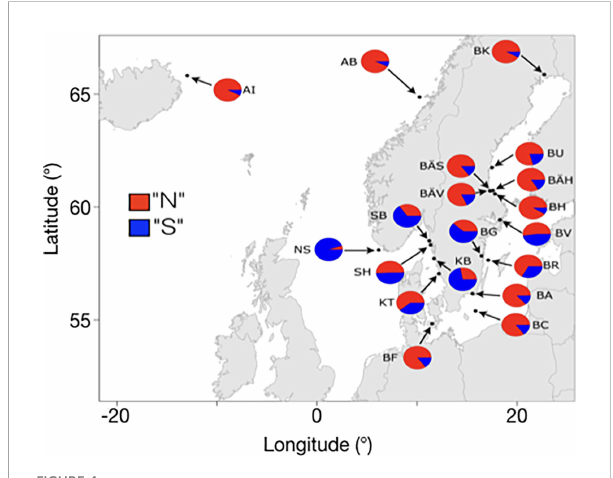
FIGURE 4 Estimated frequencies for the “ Northern ” and “ Southern ” haplotypes for the inversion on chromosome 12 in pooled population samples in the Baltic Sea and East Atlantic. Adapted from Pettersson et al., 2019, Figure